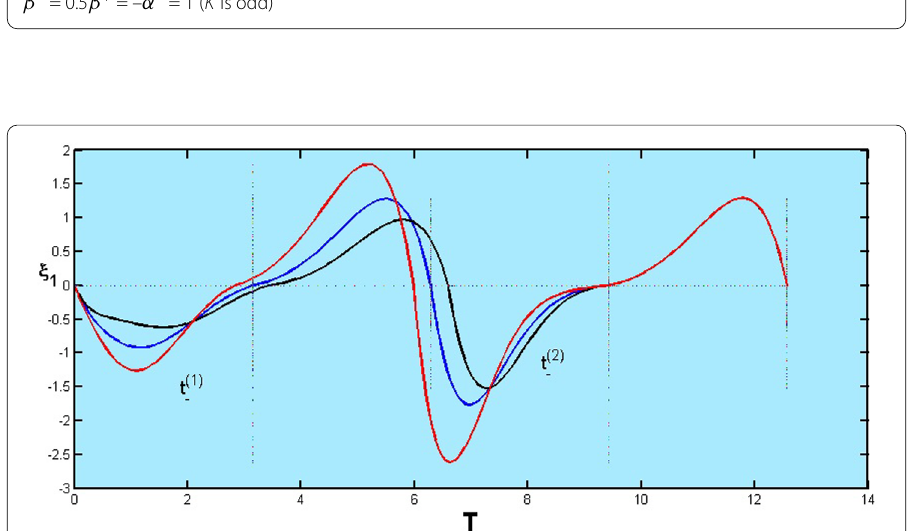
Figure 4 Three different possible intersection times corresponding to three period-two orbits when 0.5 β – = β + = – α – = 1 ( K is